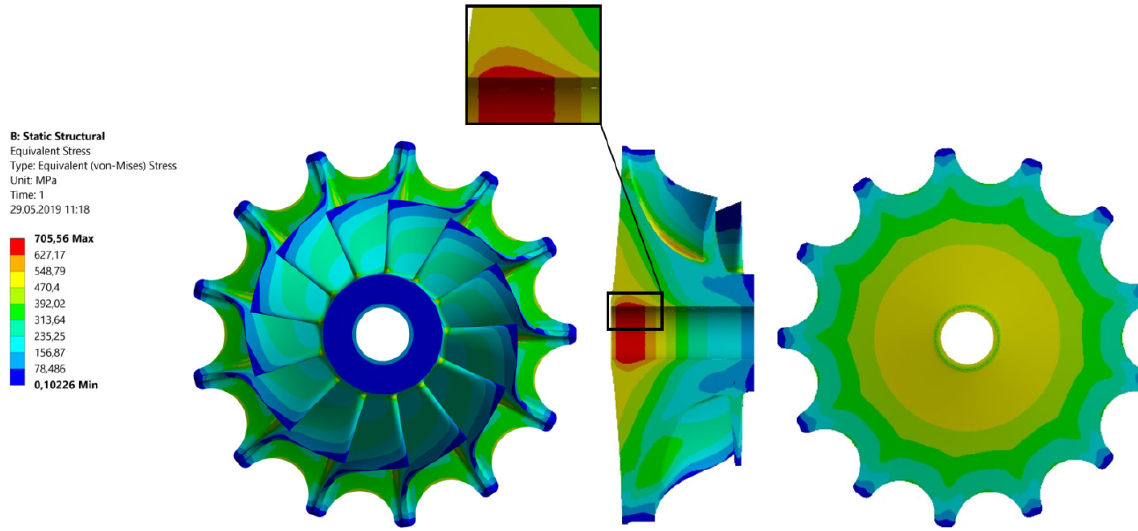
Figure 19: Front, side and rear view of turbine disc - optimisation 3 (rotational speed – 96,000 rpm; temperature – 600 ∘ C)